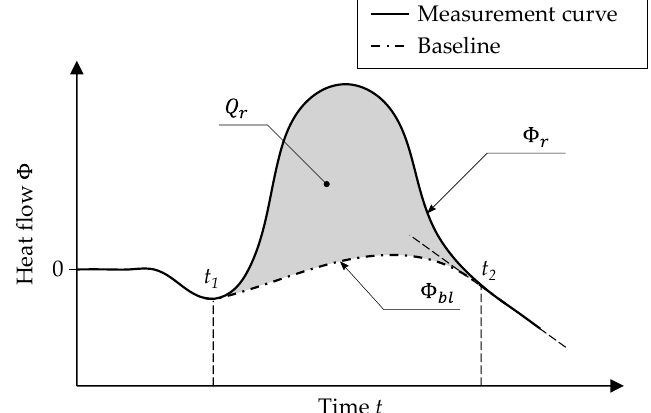
Figure 1. Procedure for determining the heat of reaction using the measurement curve and a constructed baseline.